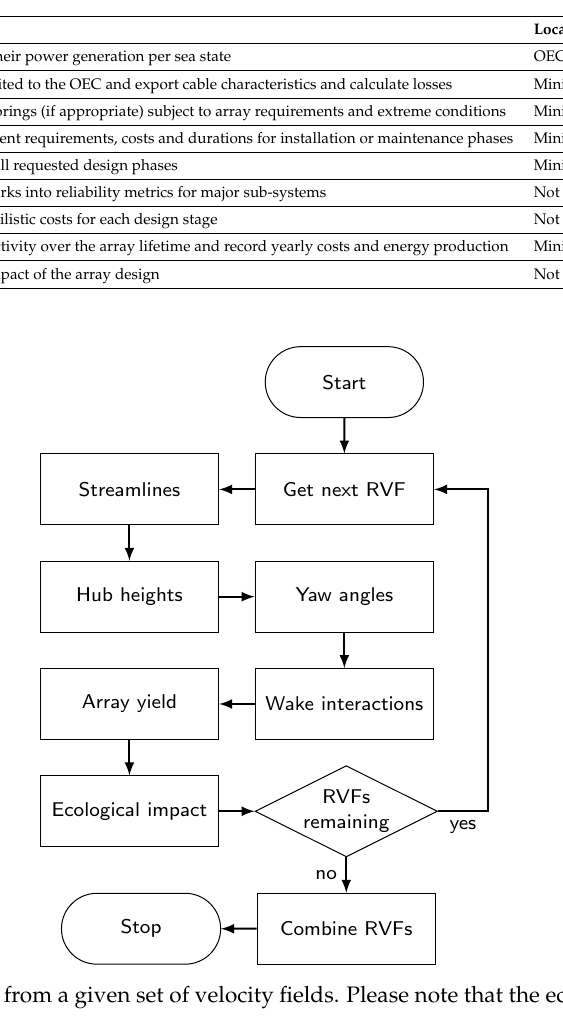
Table 2. Description of modules provided by the DTOcean software. Reproduced from [25].